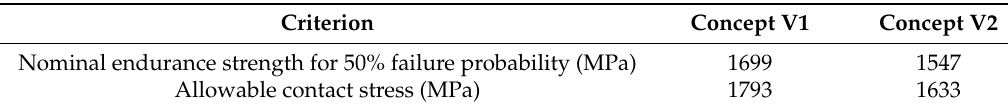
Figure 15. Examples of the typical tooth flank condition at the end of the test runs for various nominal contact stresses and load cycles (tooth width is 14 mm). Table 6. Experimentally ‐ determined endurance limit for pitting.